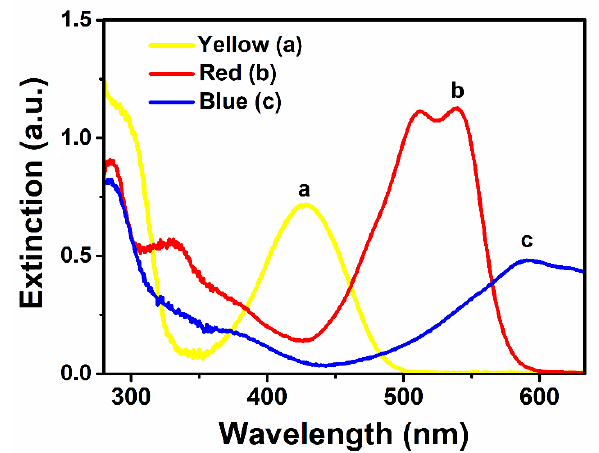
Figure 1. UV-Vis extinction spectra of: ( a ) yellow G-AgNPs; ( b ) red G-AgNPs; and ( c ) blue G-AgNPs.